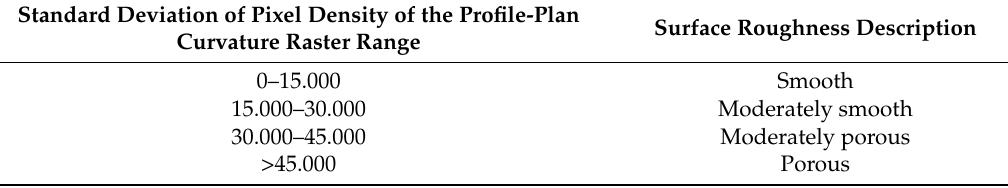
Table 4. Criteria for notch surface roughness identification (values of pixel